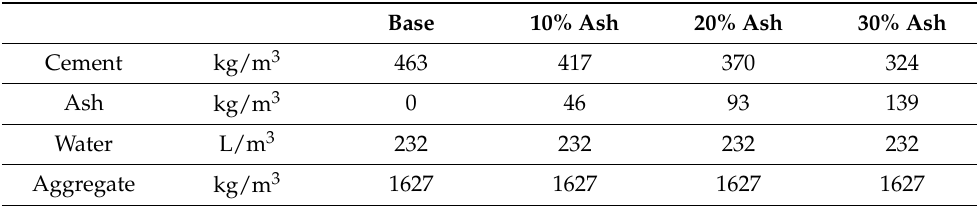
Table 4. Formulations for concrete of strength class C 25/30 with secondary materials to substitute cement through ash. Base 10% Ash 20% Ash 30% Ash Cement kg/m 3 463 417 370 324 Ash kg/m 3 0 46